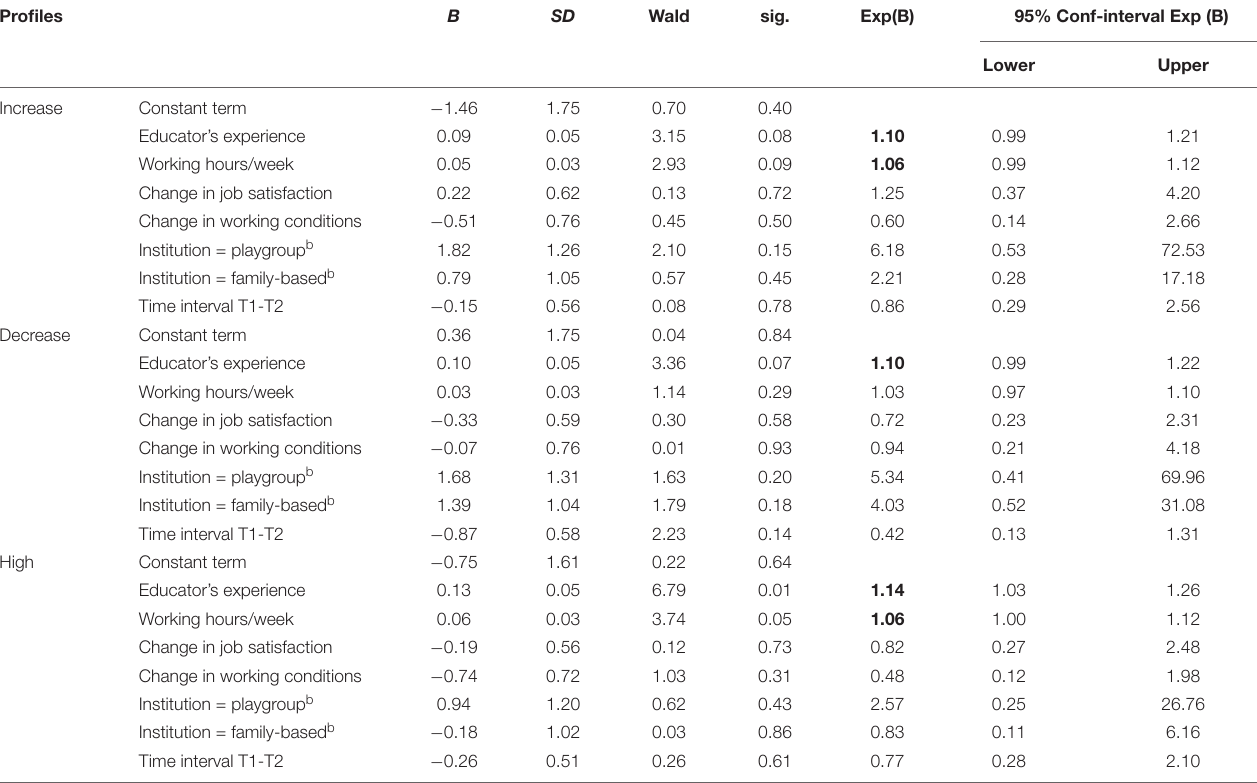
a Reference = low profile; b Reference = centre-based; Significant values are in